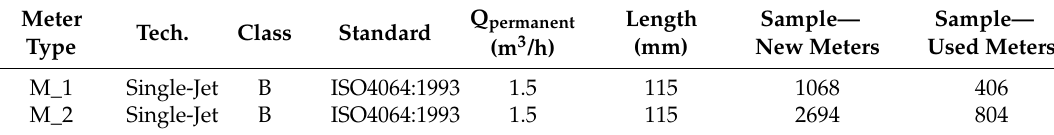
Table 1. The technical and metrological characteristics of the meters sample.